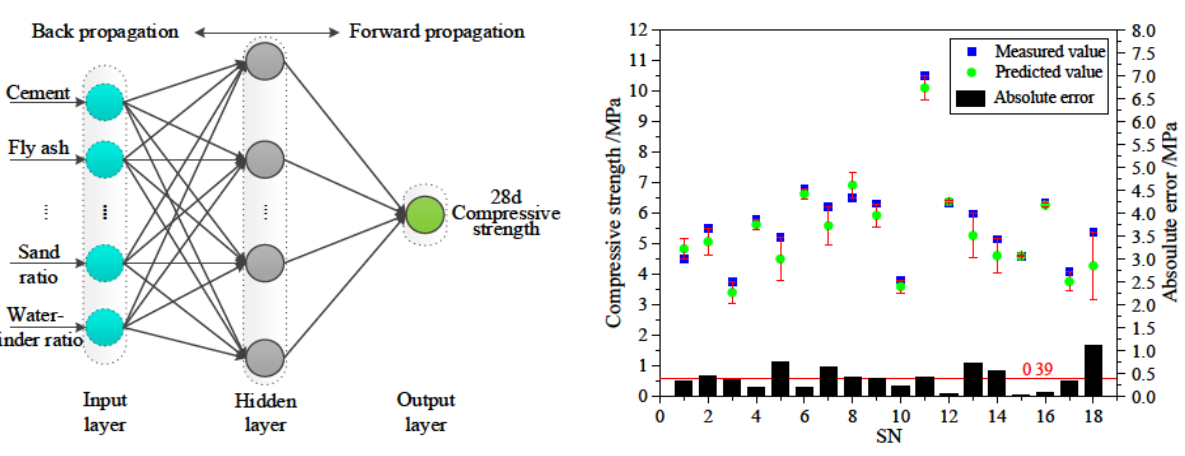
Figure 7: Comparison of measured and predicted values of 28d compressive strength